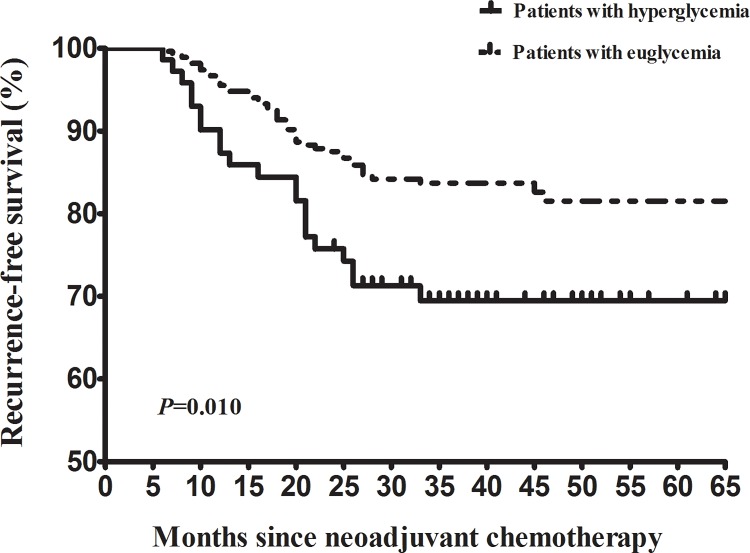
Kaplan–Meier survival curves for cancer-specific survival of cervical cancer patients receiving neoadjuvant chemotherapy for bulky early stage disease.The P values were determined by the log-rank test.